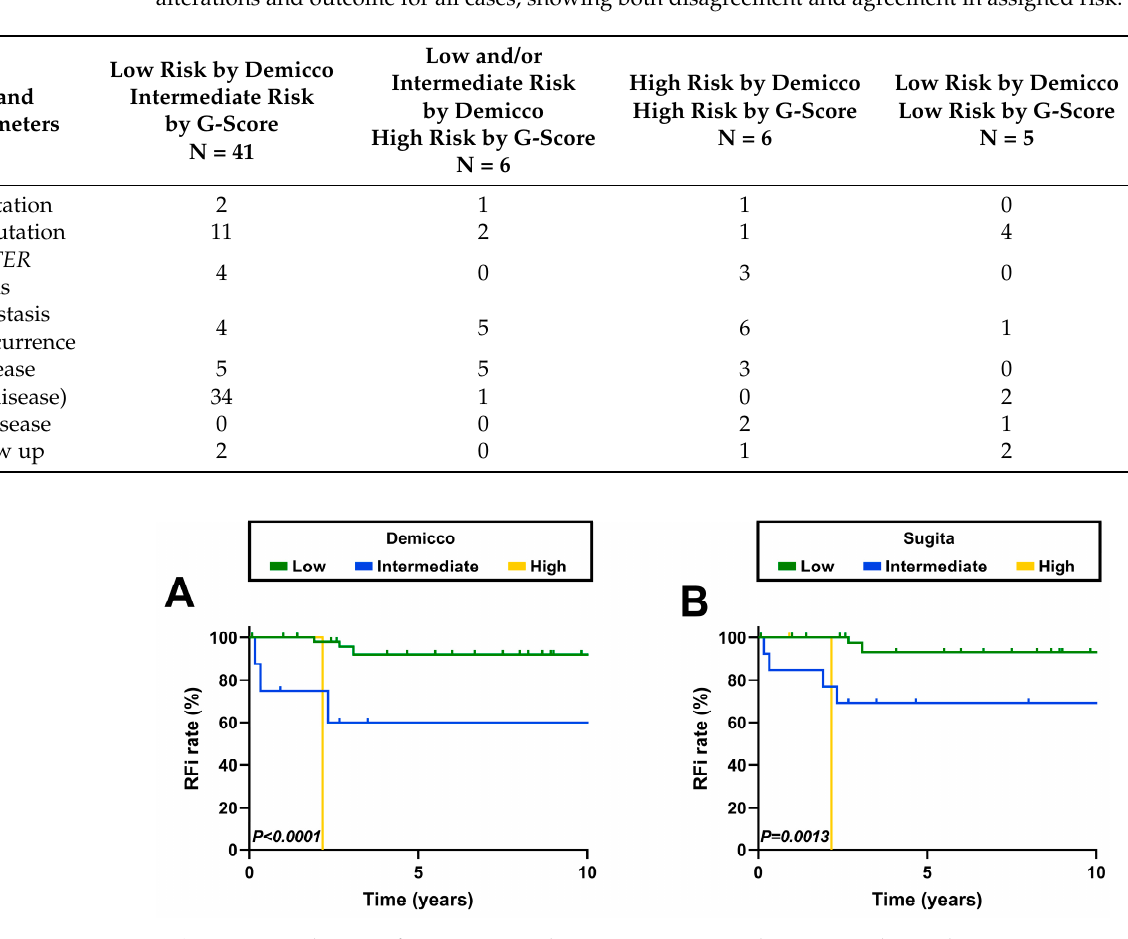
Table 2. Correlation between Demicco et al., and G-Score RSS for recurrence/metastasis, molecular alterations and outcome for all cases, showing both disagreement and agreement in assigned